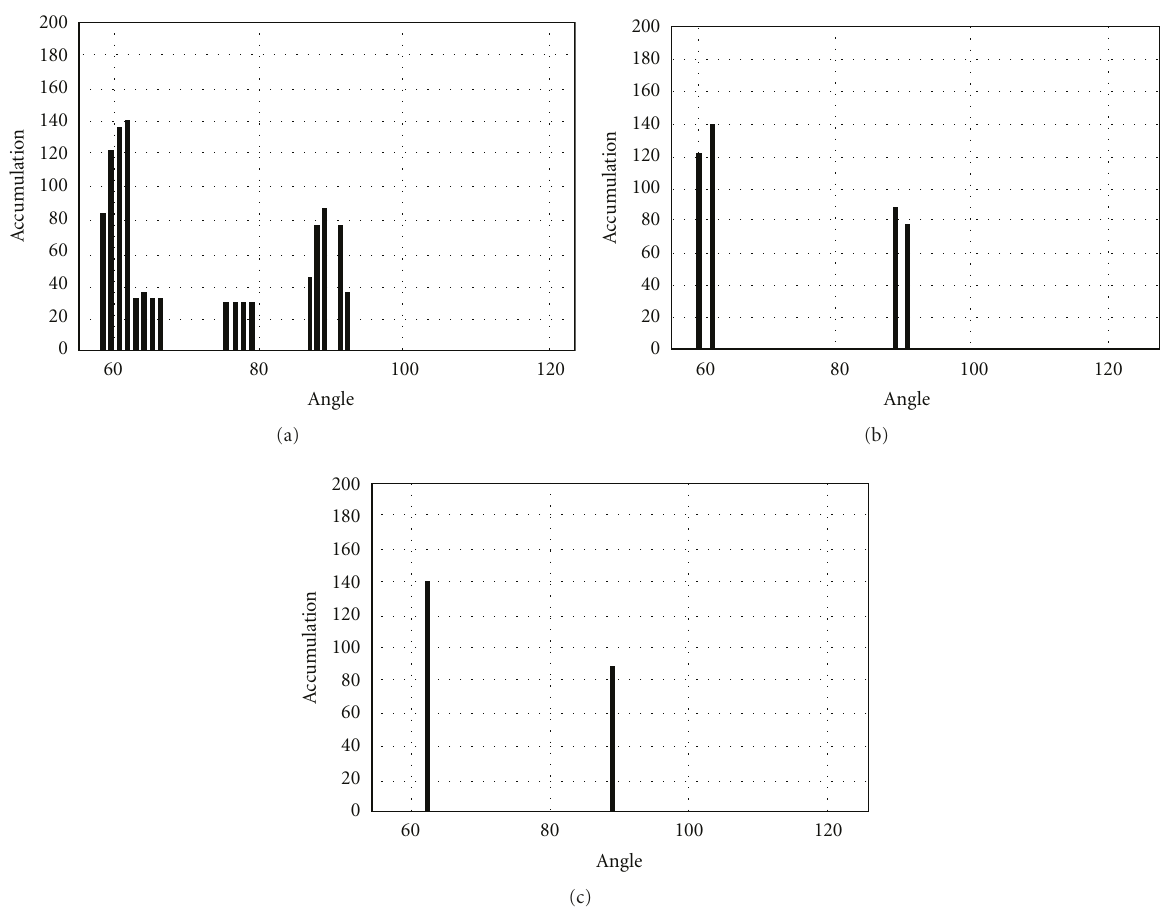
Figure 17: The processes of histogram post-processing, where x -axis and y -axis represent the angles of polar histograms and the accumulation amount on each angle, respectively. (a) The polar histogram of Figure 13. (b) The histogram of (a) after the trapezoid histogram elimination, low singleton histogram elimination and the peak searching procedure. (c) Local peak histogram.